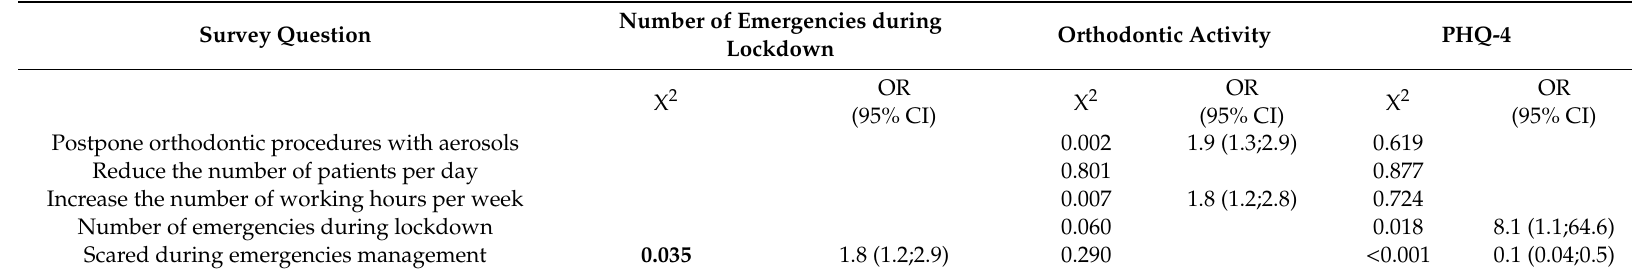
Table 5. Chi-square test and regression analysis for questions about emergencies and changes in clinical procedures and work organization and orthodontic activity, PHQ-4.